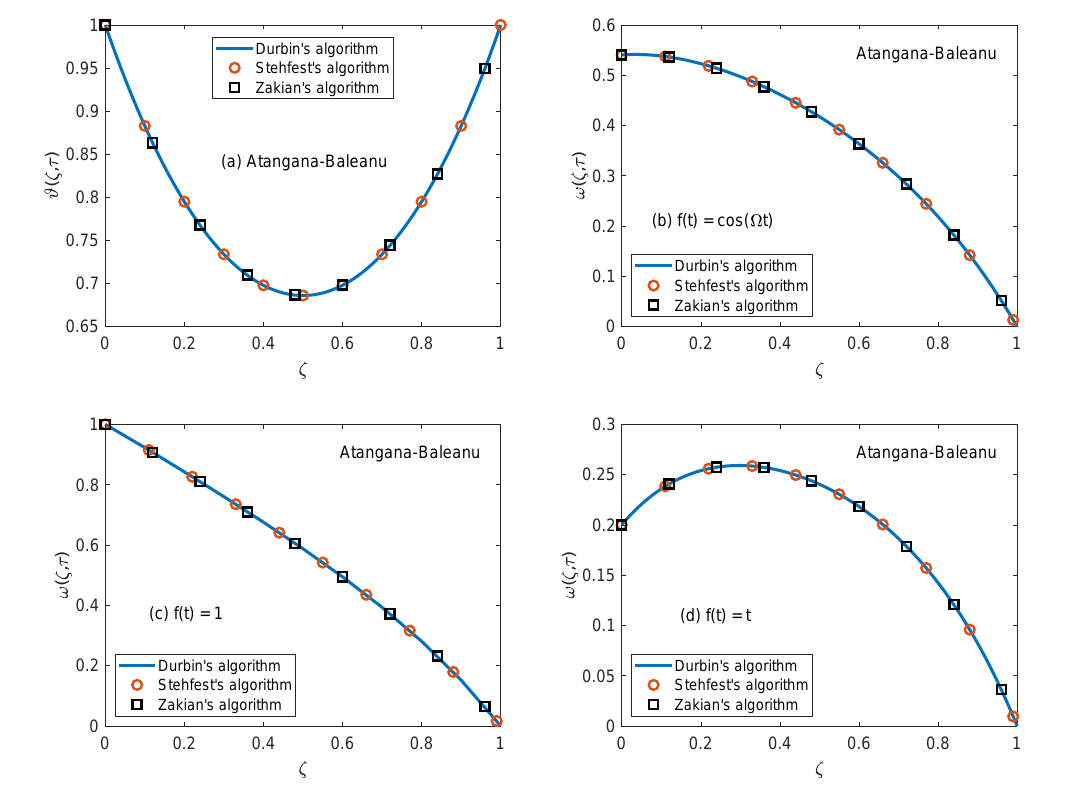
Figure 18. Validation of temperature and velocity fields developed through AB model.